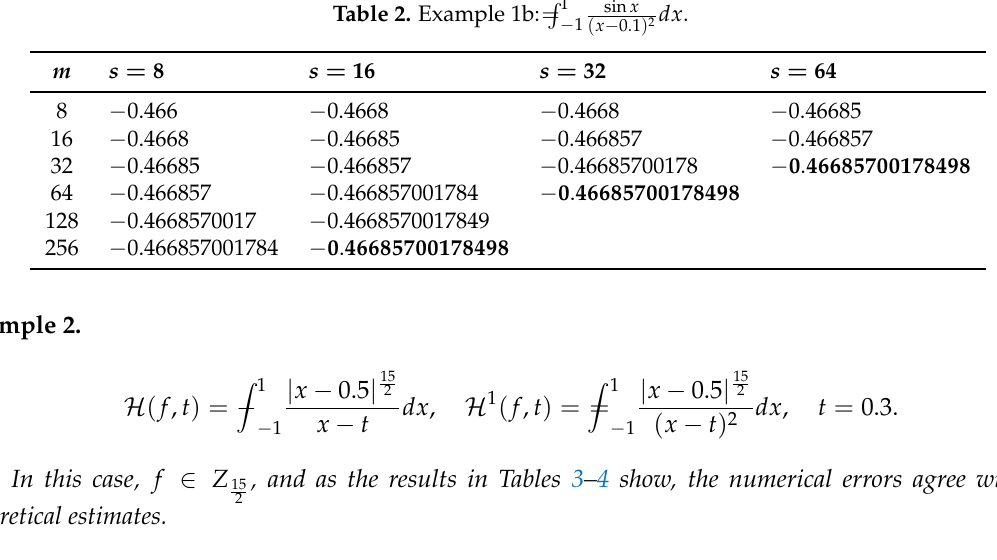
Table 2. Example 1b: